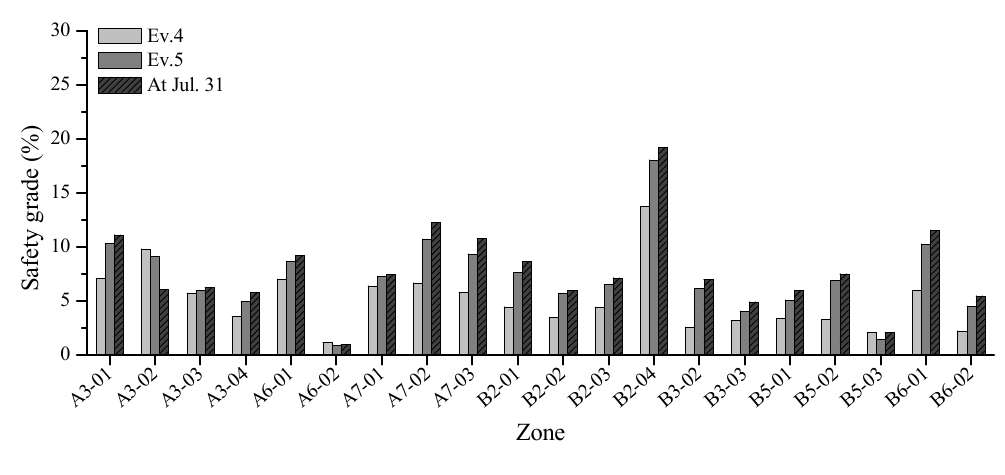
Figure 9. Structural safety during construction